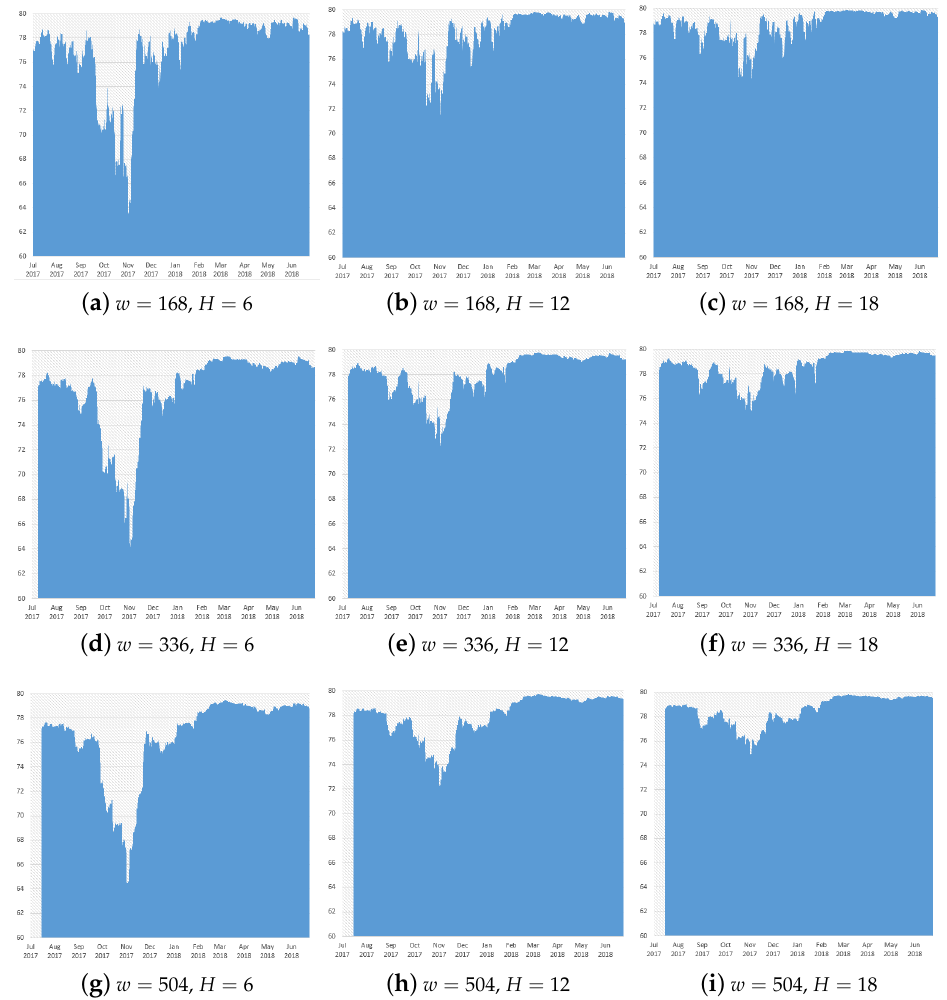
Figure 6. Robustness analysis. Note : The figure shows the TSI with estimation window widths w of 168, 336, and 504 h—corresponding to 1, 2, and 3 weeks, respectively—and predictive horizons H of 6, 12, and 18 h. Values are expressed in percentage